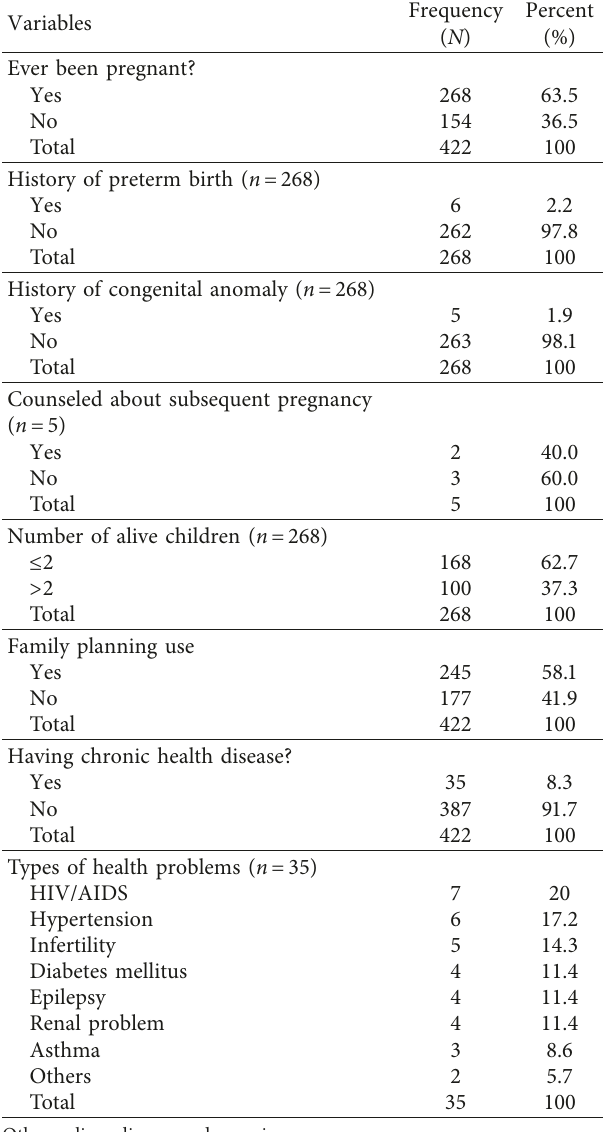
Table 2: Reproductive characteristics of women in Adet, Gojjam, Northwestern Ethiopia, 2016 ( n � 422).